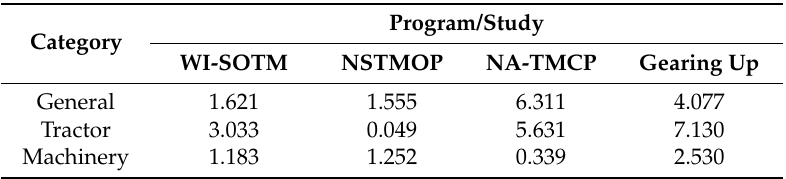
Table 5. Contribution of Each Cell to Chi-Square Independence Test (X 2 ).